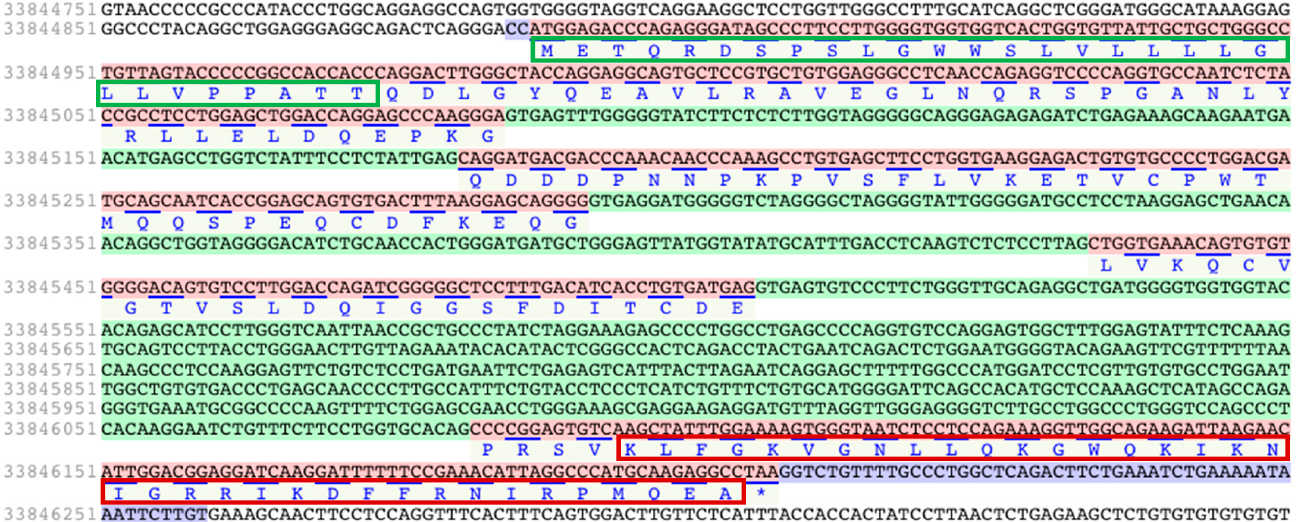
Figure 2. Nucleotide and amino acid sequence of the gene coding for the X1 variant of the Iberian mole ( Talpa accidentalis) . The nucleotide sequence of the introns is shaded in green and the exons are in red. The translated sequence of the exons is in blue. The mRNA ends of the transcript variant X1 (1375 bp) is shaded in purple. The elastase cleaving site was predicted for the first valine or alanine of the amino acid sequence from the fourth exon. The sequence of the signal peptide is within the green box. The sequence of the antimicrobial portion of the putative peptide for the cathelicidin of Talpa occidentalis is within the red box. The figure was a capture of the NCBI Genome Data Viewer using the tool “Sequence text view”.